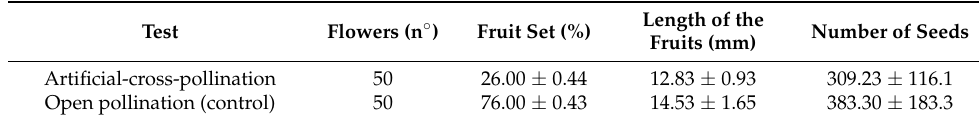
Table 2. Fructification rate, average ( ± standard deviation), number of seeds and average ( ± standard deviation) size length of the fruits obtained from open pollination and artificial-cross-pollination treatments in Ludwigia nervosa .